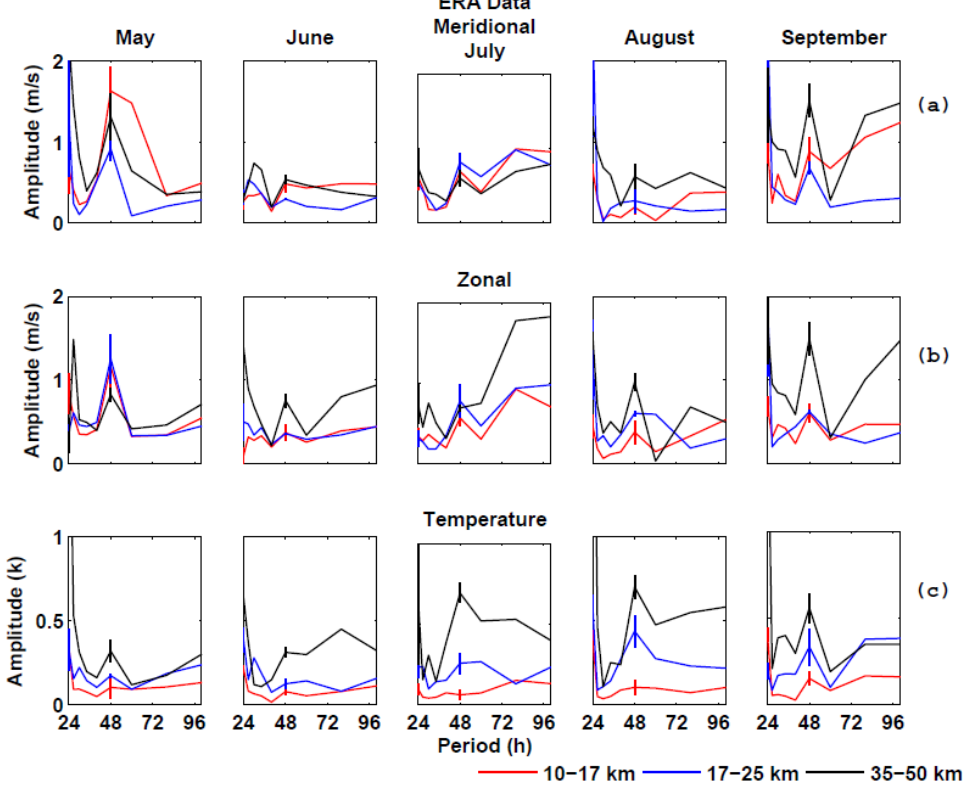
Fig. 4. Same as Fig. 3 but for ERA